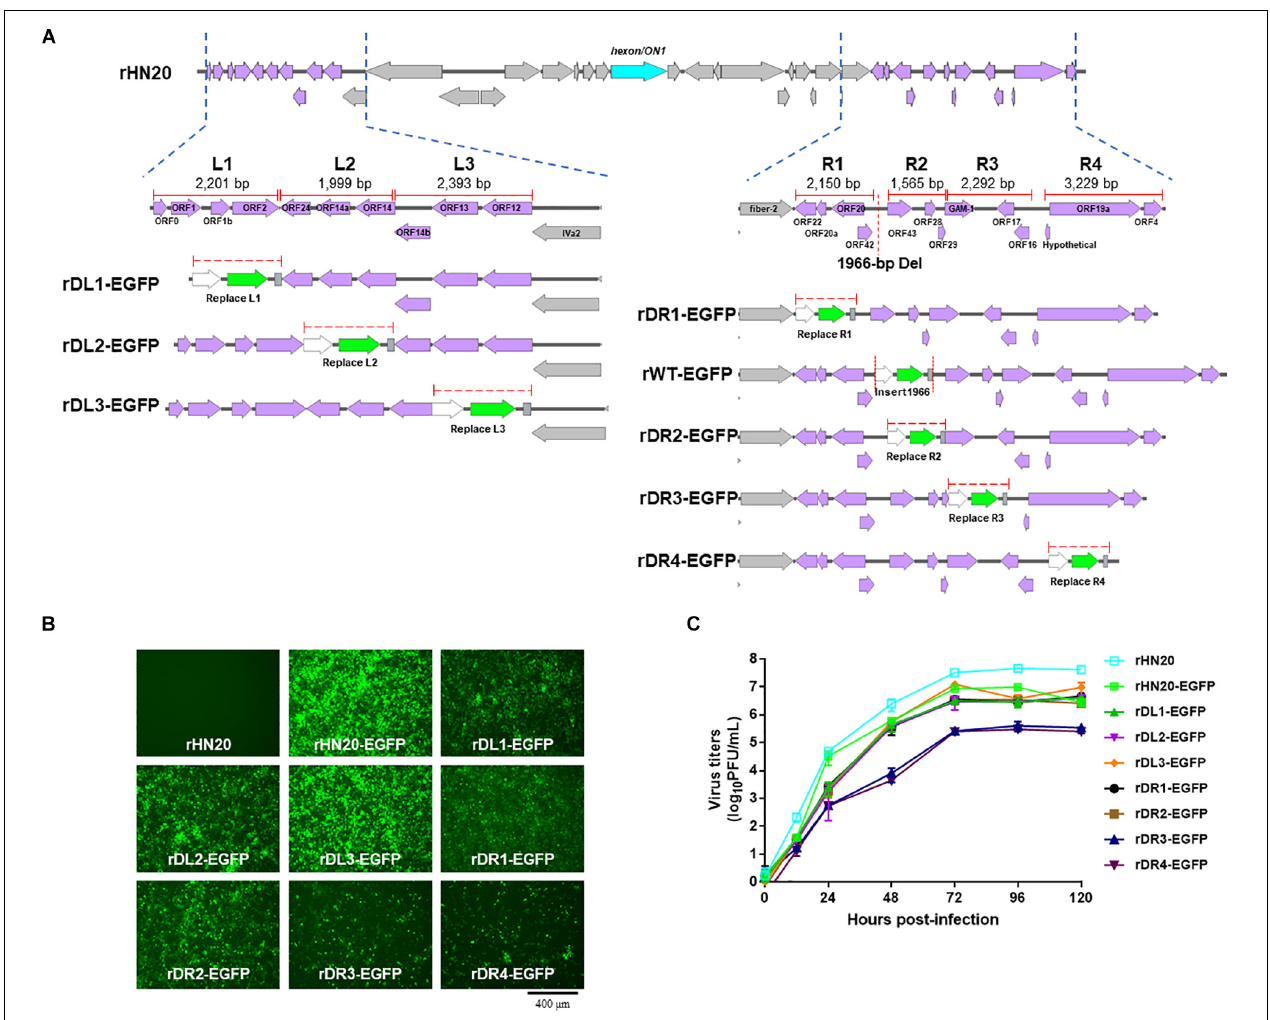
FIGURE 4 | FAdV-4 non-essential genes serve as insertion sites of foreign gene. (A) Construction of recombinant FAdV-4 expressing EGFP gene. The left ORFs of FAdV-4 are divided into the L1, L2, and L3 regions, and the right ORFs are divided into the R1, R2, R3, and R4 regions. The length of each region is indicated and each region is individually replaced by an EGFP expression cassette. (B) Green fluorescence in LMH cells infected with different recombinant fluorescent viruses. (C) Replication kinetics of different recombinant fluorescent